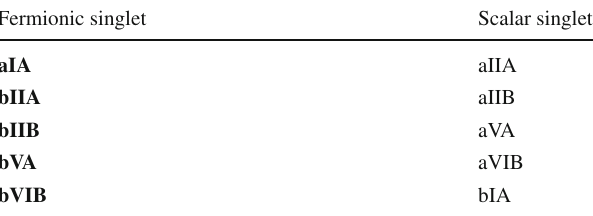
Table 2 Models containing a singlet DM candidate. Only the models containing a fermionic singlet DM candidate, highlighted in red, are considered in this work. Note that the value for X is fixed within each model by the condition that there is a singlet DM candidate